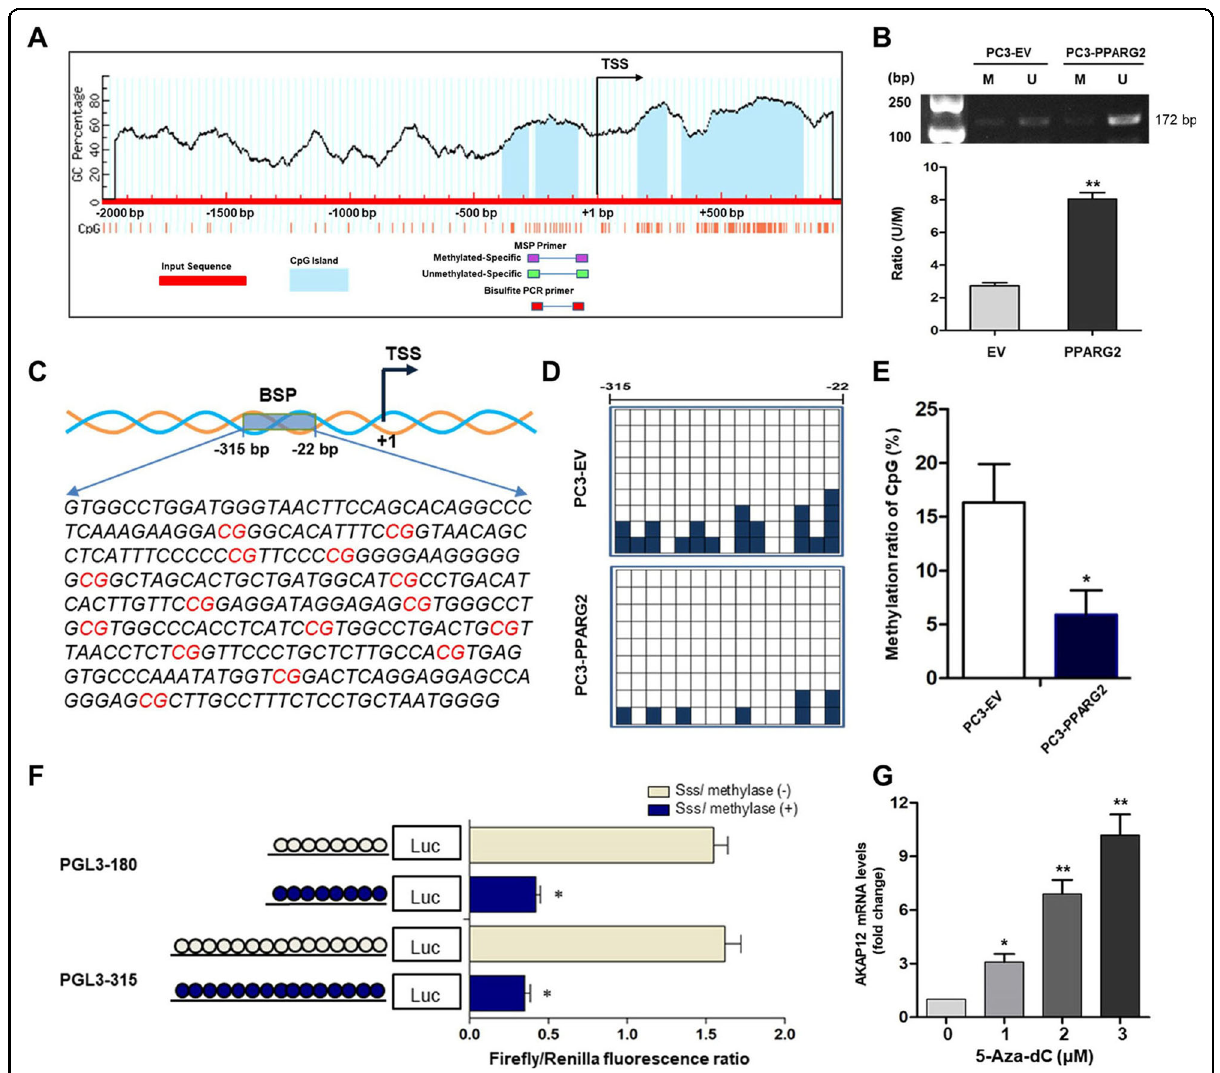
Fig. 6 Upregulated PPARG2 induces demethylation of the AKAP12 promoter region in vitro. A Scheme for the location of the CpG islands near the TSS in AKAP12 gene. The CpG sites were indicated by vertical red lines. The regions for MS-PCR and BSP were indicated. TSS, translation start site. B Representative results of methylation analysis by MS-PCR in PC3 cell line transfected with EV or PPARG2 plasmid. M, methylation; U, unmethylation. ** P < 0.01 vs. EV group. C Schematic region from − 315 to − 22 bp for BSP including 15 CpG sites in the AKAP12 gene promoter area. D BSP analysis of methylation status of the AKAP12 gene promoter. It is noteworthy that each small square indicates one clone. A total of nine clones were subjected to bisul fi te sequencing. The methylated clones of individual CpG sites are labeled in dark blue. E The methylated clone ratio at − 315 to − 22 bp region of CpG sites. * P < 0.05 vs. EV group. F Two luciferase constructs treated with SssI methylase in vitro. * P < 0.05 vs. SssI methylase ( − ) group. G RT- qPCR analysis of relative AKAP12 mRNA expression in PC3 cell line treated with 5-Aza-dc at different concentrations. * P < 0.05, ** P < 0.01 vs. group of 0 µM